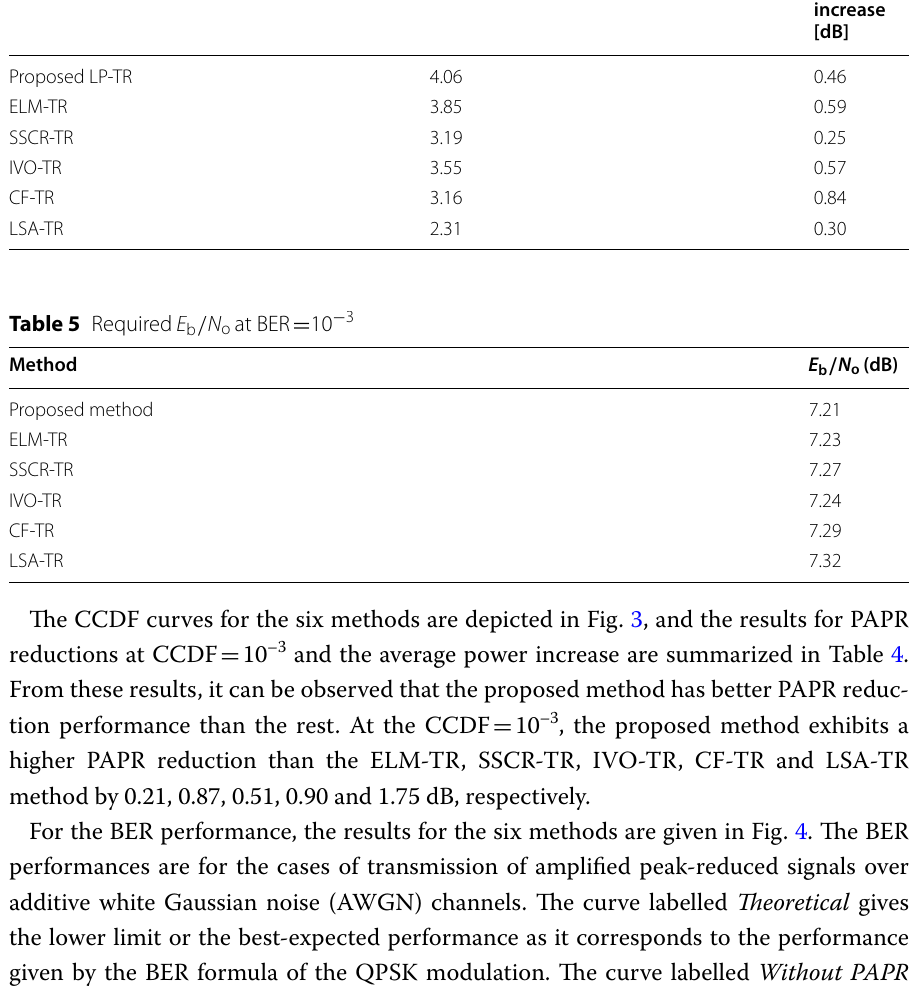
Table 4 PAPR reduction and average power increase Method